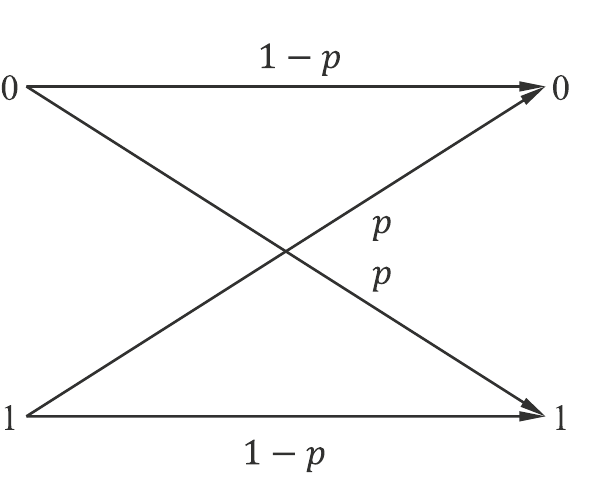
Figure 6. Binary symmetric channel.